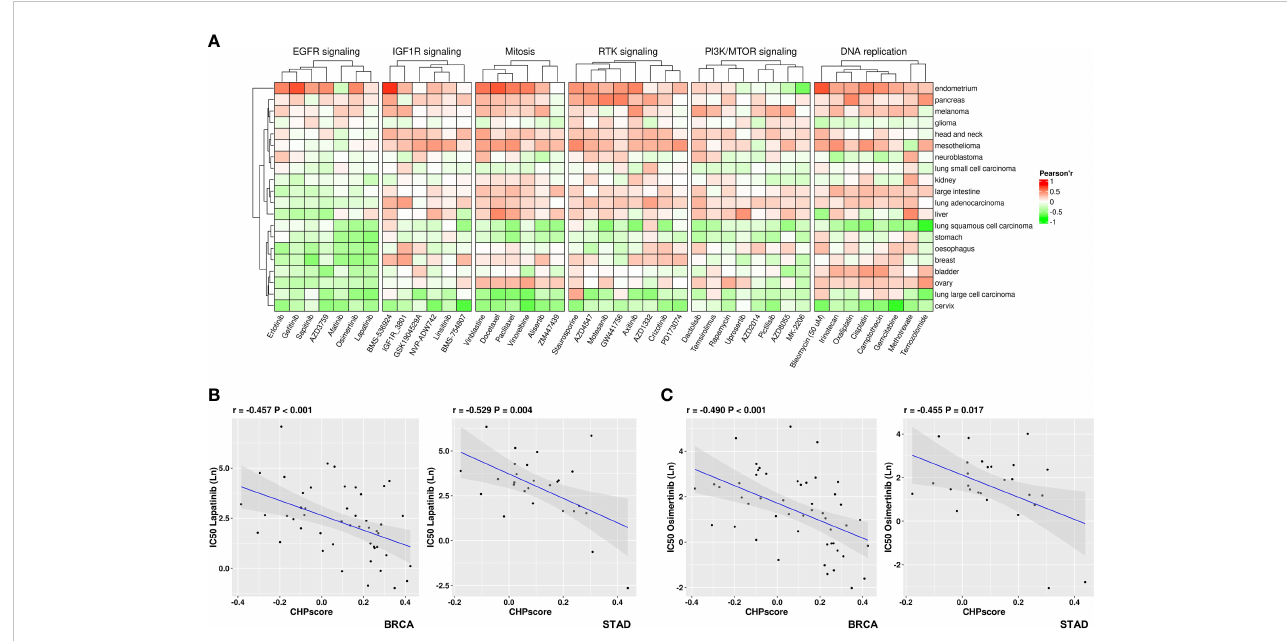
FIGURE 5 Sensitivity of tumors with high CHP score to different drugs in the GDSC database. (A) Correlation coef fi cient between the CHP score and the IC50 values of speci fi ed drugs in different pathways or targets. (B) Correlation between the CHP score and the IC50 values of Lapatinib in breast cancer (left) or gastric cancer (right). (C) Correlation between the CHP score and the IC50 values of Osimertinib in breast cancer (left) or gastric cancer